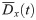
Estimates for cohort of individuals born before 1945, for years 1999–2013, from model (12), (13) calibrated using data listed in S4 Table and S5 Table.Blue circles denote observed annual numbers of HCC and hepatitis C diagnoses for this cohort. A: Model estimates of total number of HCC diagnoses. B: Model estimates of total number of hepatitis C diagnoses. C: Model estimates of CHC prevalence rate Rx(t). D: Model estimates of proportion of CHC population undiagnosed D¯x(t).